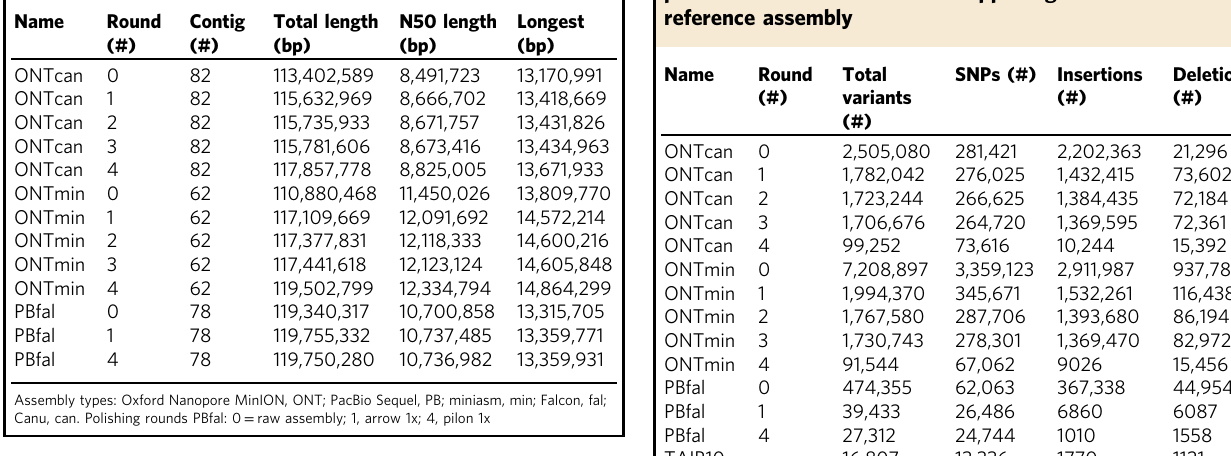
Table 2 Variant calling metrics of Illumina PCR-free